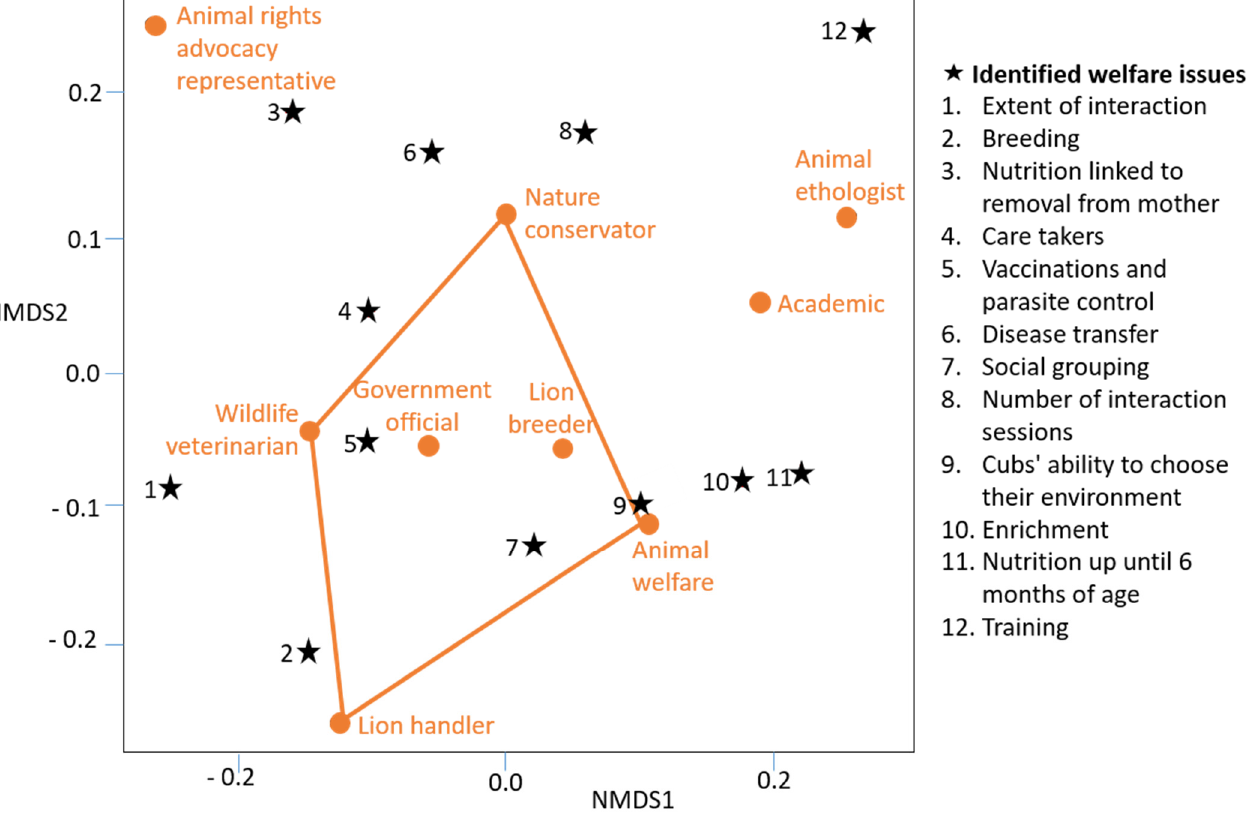
Figure 3. NMDS ordination indicating the associations between the conjoint analysis participants’ affiliation and the mean weighted utility value of the welfare attribute.